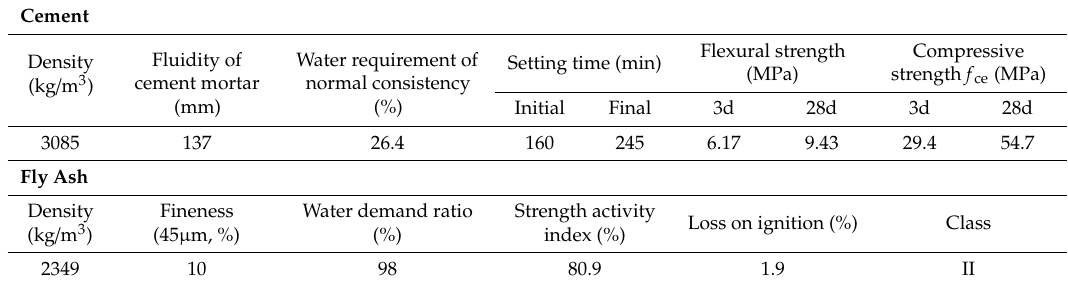
Table 6. Physical and mechanical properties of cement and fly ash.